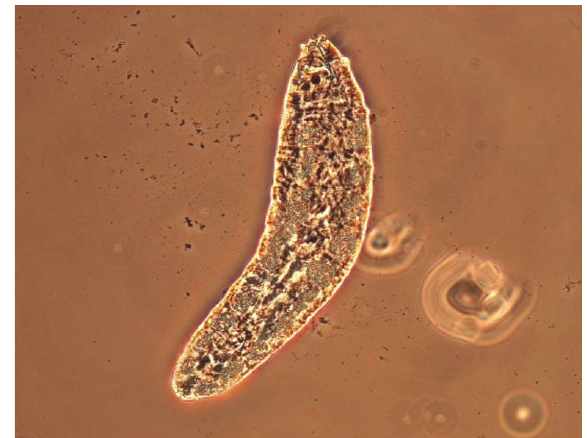
Figure 6: First instar, head and thoracic segments. The ovoid, red objectsbetweenthetentorialarmsareBolwig’sorgans.Notetherows of cuticular denticles.